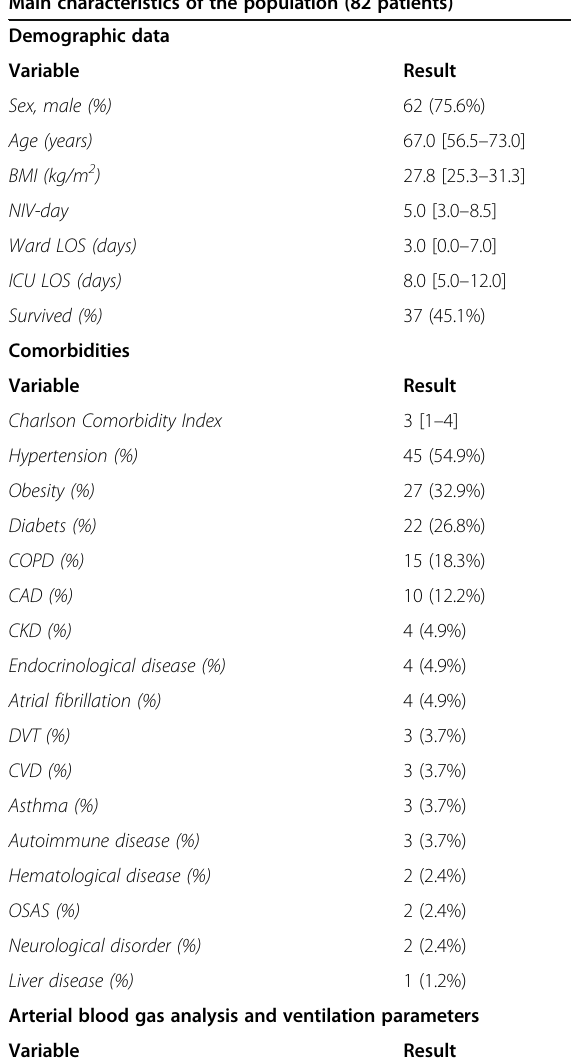
Table 1 Demographic and clinical features of the sample Main characteristics of the population (82